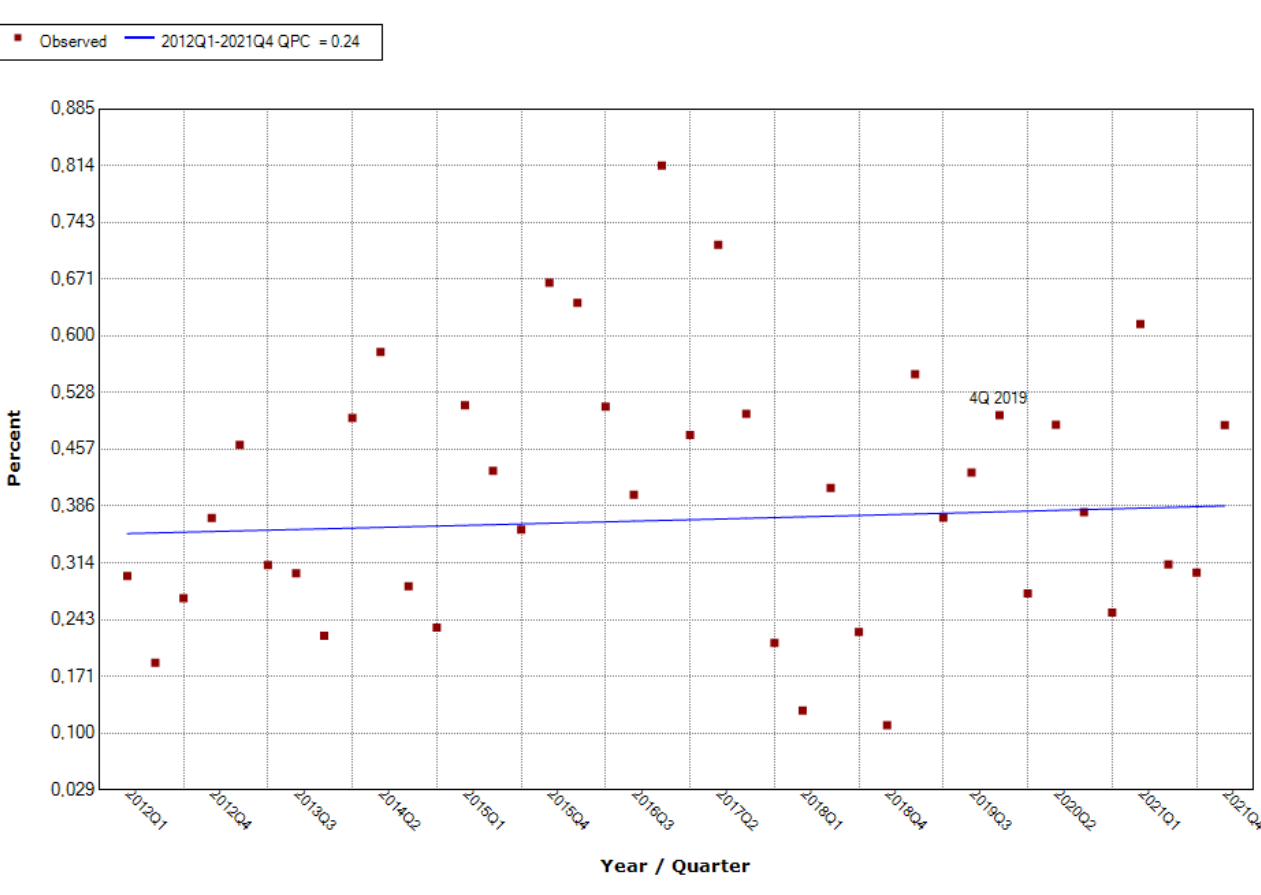
Figure A6. Percentage of products containing white mulberry in individual quarters in the period from 2012 to 28 November 2021. Joinpoints mark trend turning points. The date above the observation indicates the moment of publication of the scientific opinion/resolution.